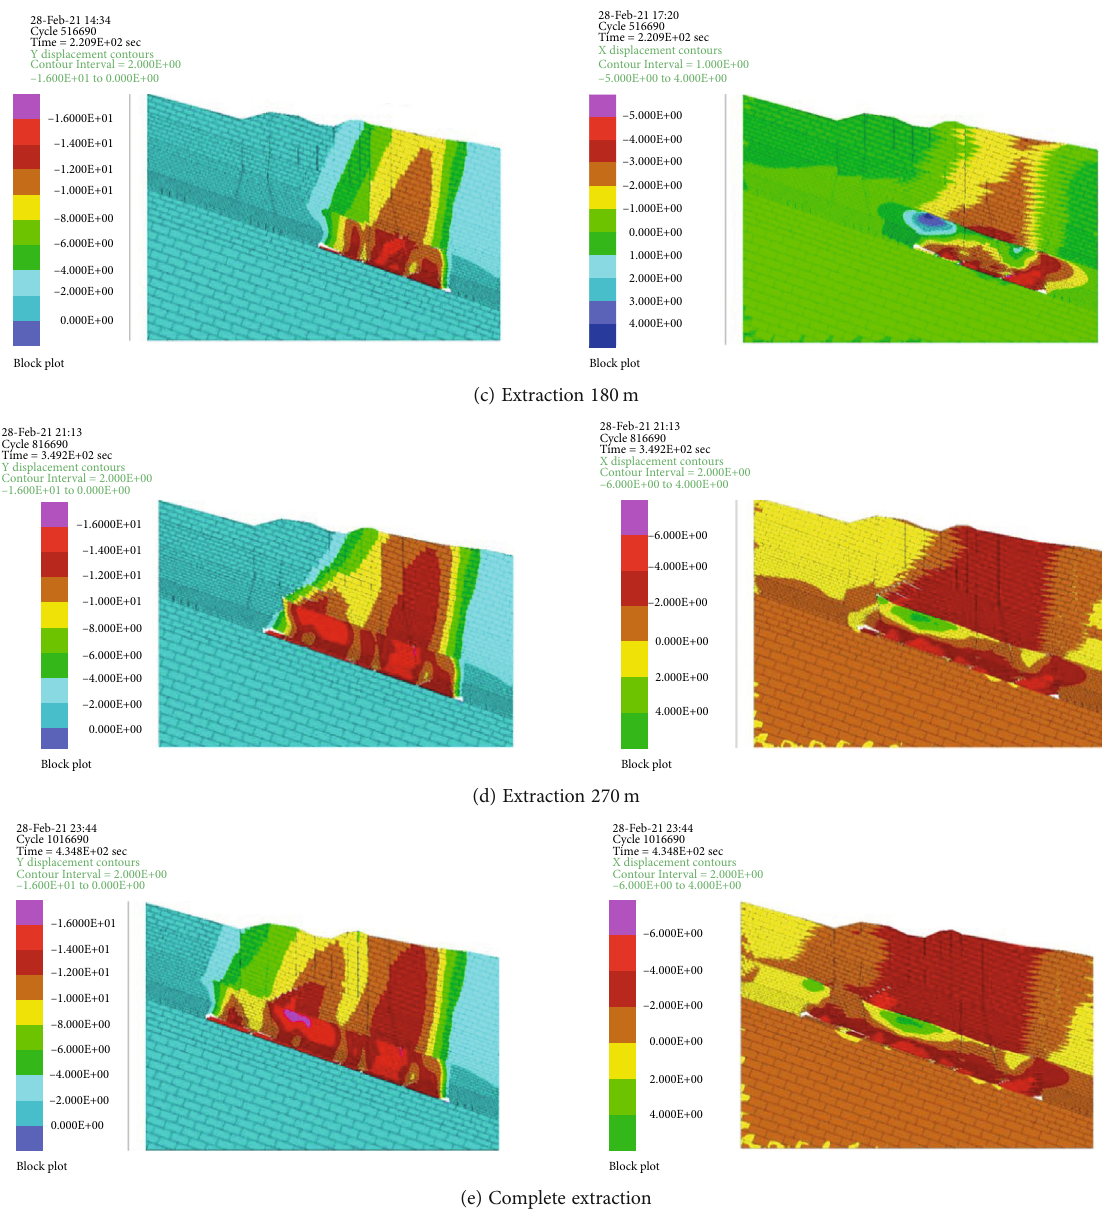
Figure 13: Numerical simulation results of No. 92 pillar back fi